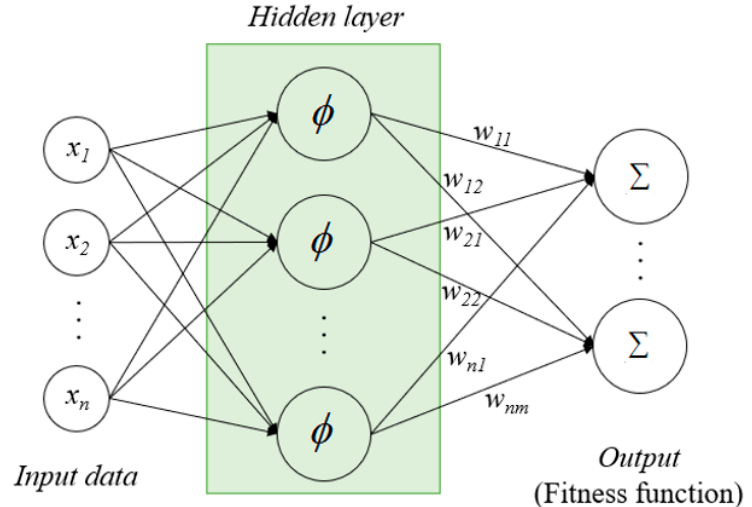
Figure 8. Schematic of the radial basis neural network. Processes 2020 , 8 , x FOR PEER REVIEW 10 of 20